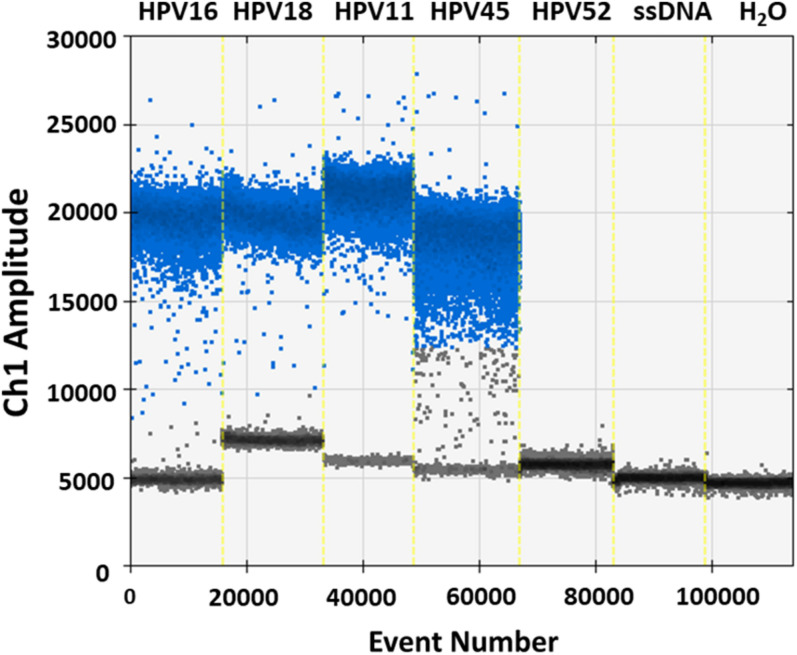
Representative analysis of ddPCR specificity. Vertical lines represent the fluorescent amplitude of pUC19 and pGEM1 plasmids, which contain the complete genomes of HPV16/18/11 and HPV45, respectively, as well as pUC19, which contains the complete genome of HPV52, employed as negative control. Two others negative controls are included: one control contains the salmon sperm DNA (ssDNA), whereas the additional negative control is represented by ddH2O without DNA.